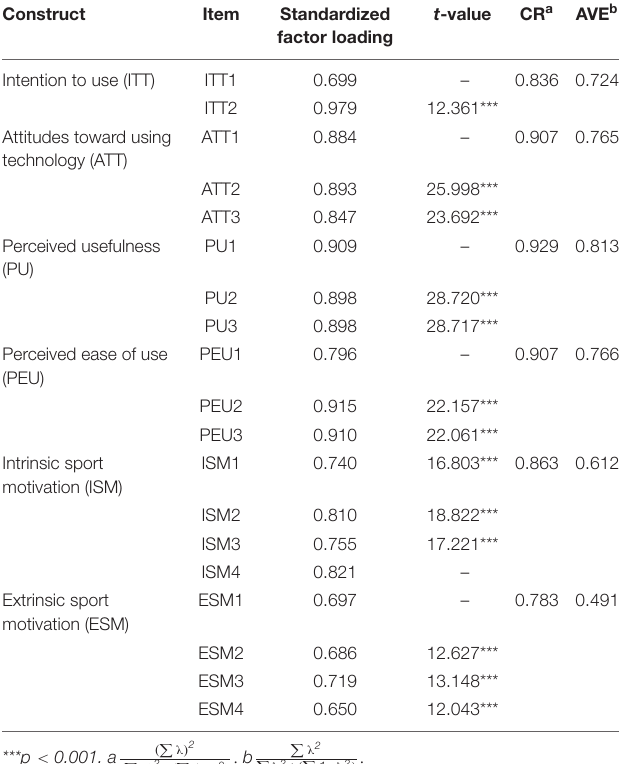
TABLE 2 | Results of the measurement model, composite reliability (CR), and average variance extracted (AVE).